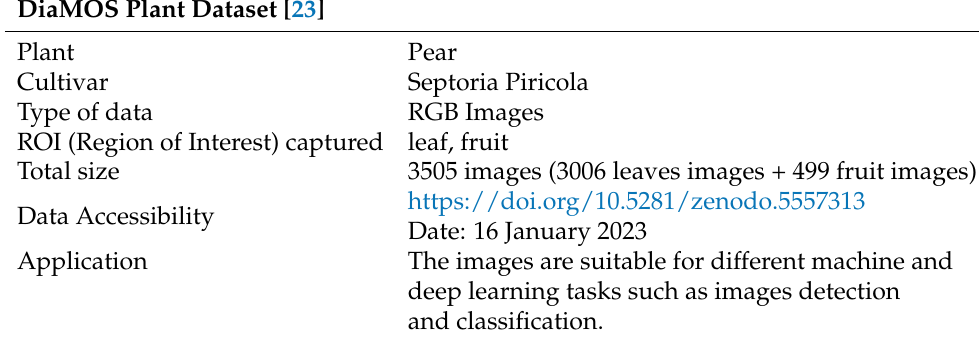
Table 1. Dataset description.